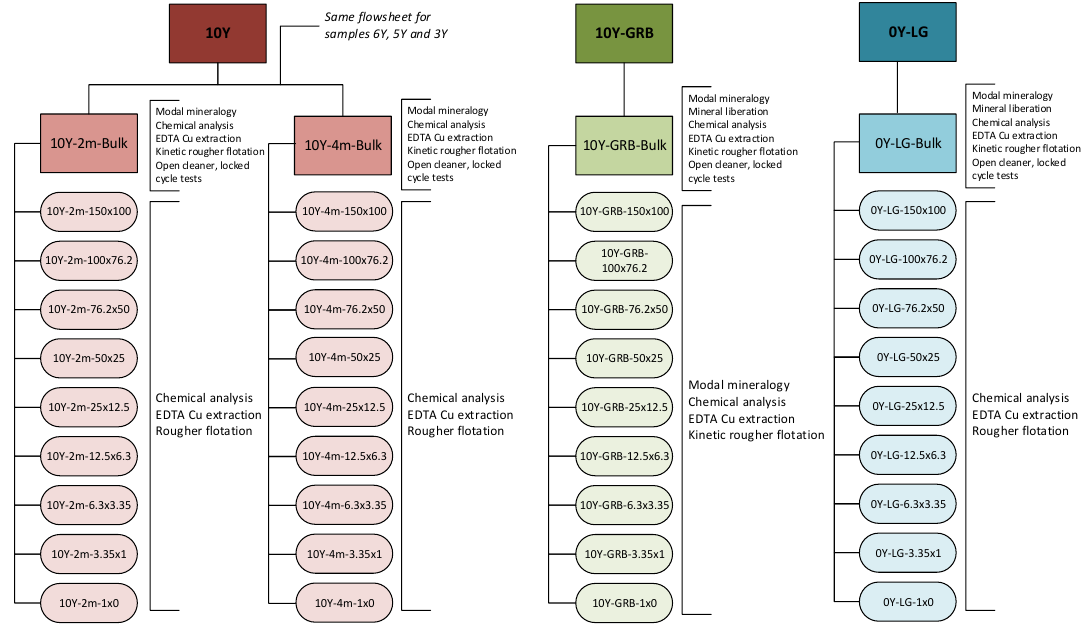
Figure 2. Sample identification and set of tests performed for each